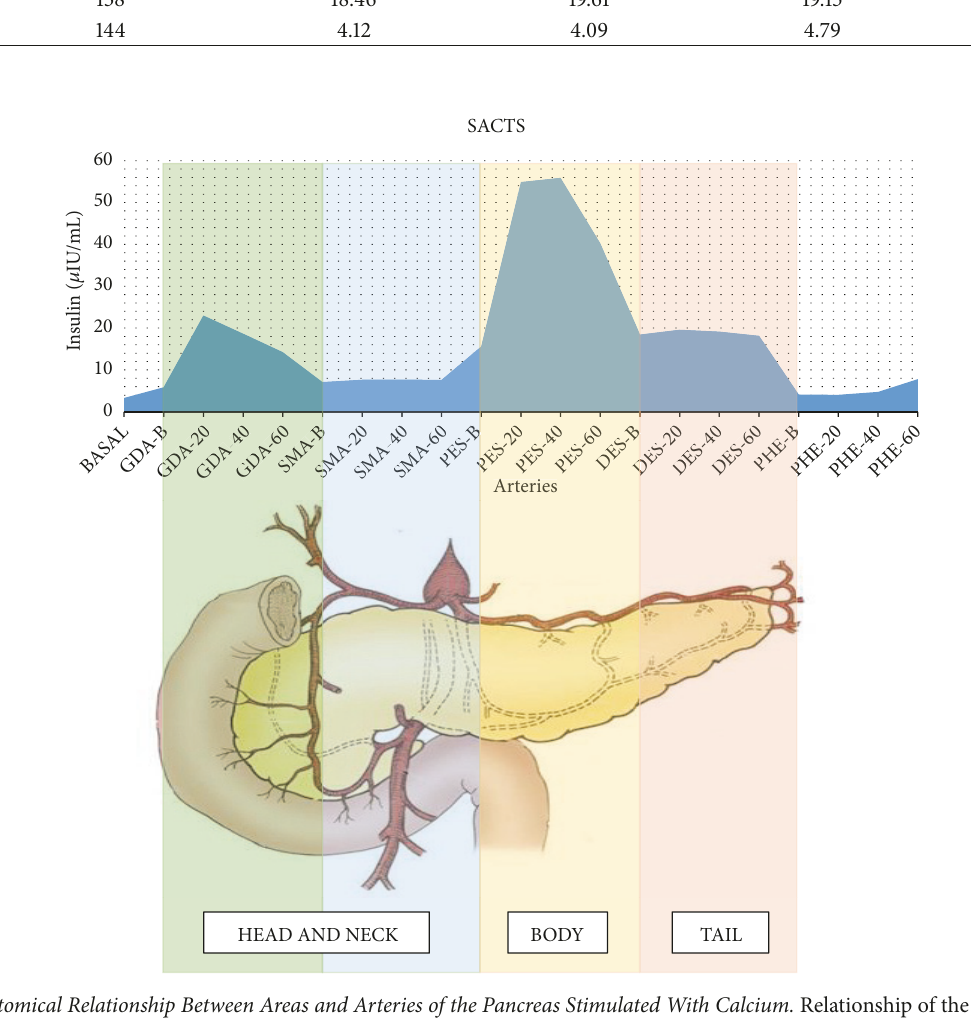
Figure 1: Anatomical Relationship Between Areas and Arteries of the Pancreas Stimulated With Calcium. Relationship of the main arteries of the pancreas and the areas that irrigate: gastroduodenal (GDA), superior mesenteric (SMA), and splenic artery. The splenic artery was divided into proximal (PES) and distal (DES) to differentiate the tail of the body. The proper hepatic artery was included to rule out tumor activity in the liver (PHE). The numbers indicate the seconds at which the sample was taken after the calcium injection. This suggests the most likely localization of the